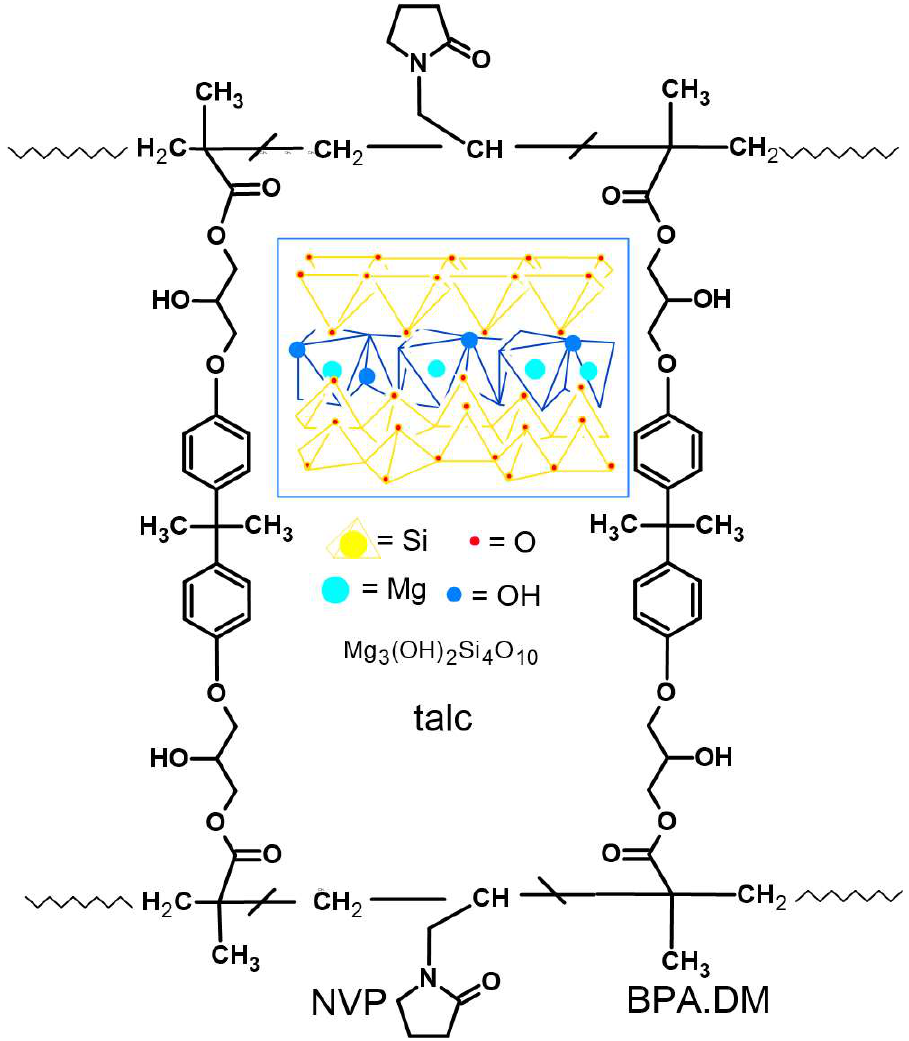
Figure 1. Assumed fragment of the composite structure.